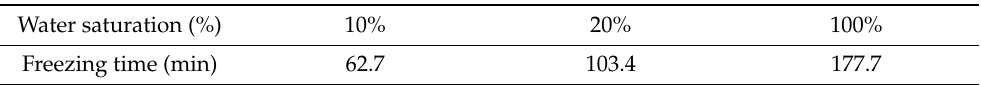
Figure 7. Temperature variation curve of the center position of the connecting line between two frozen holes under different water saturation. Table 4. Freezing time at the center of the connection line of simulated frozen wall under different water saturation